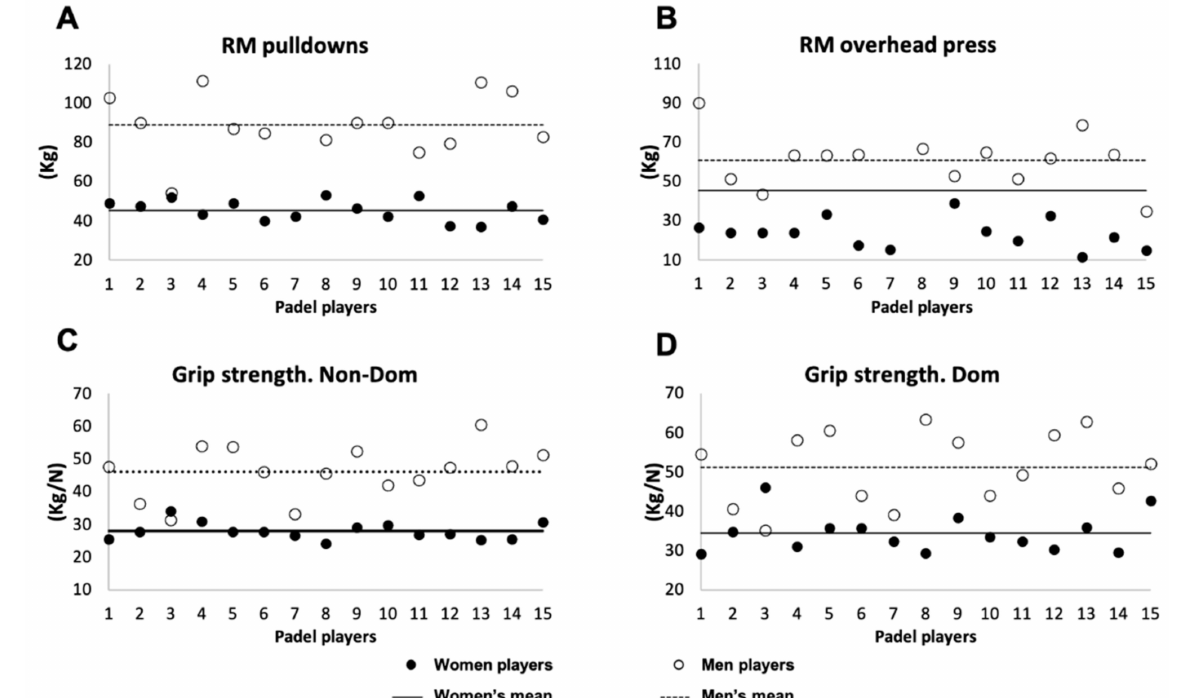
Figure 2. Mean and individual values in the four largest measurements concerning gender differences. RM: one repetition maximum. Non-Dom: non-dominant; Dom: dominant. Kg: kilogram. ( A ) one repetition maximum pulldowns; ( B ) one repetition maximum overhead press; ( C ) grip strength Non-dominant arm; ( D ) grip strength dominant